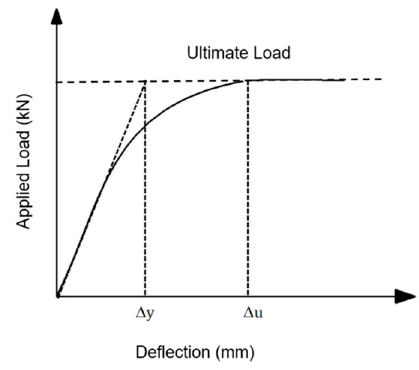
Figure 10. Determination procedure of the ductility